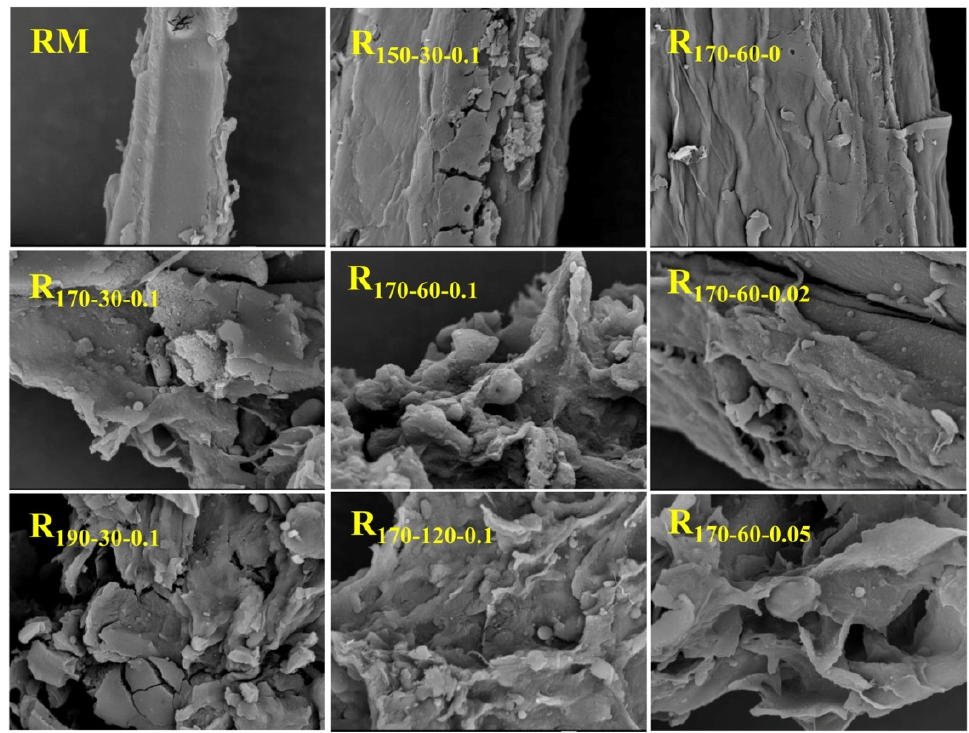
Figure 3. SEM images of the raw material and resulting solid residues with different systems.